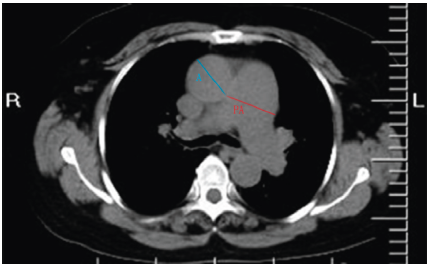
Figure 1: Measurement of PA and A diameters. PA, pulmonary artery; A, aorta. Diameters of PA and A were measured at the level of